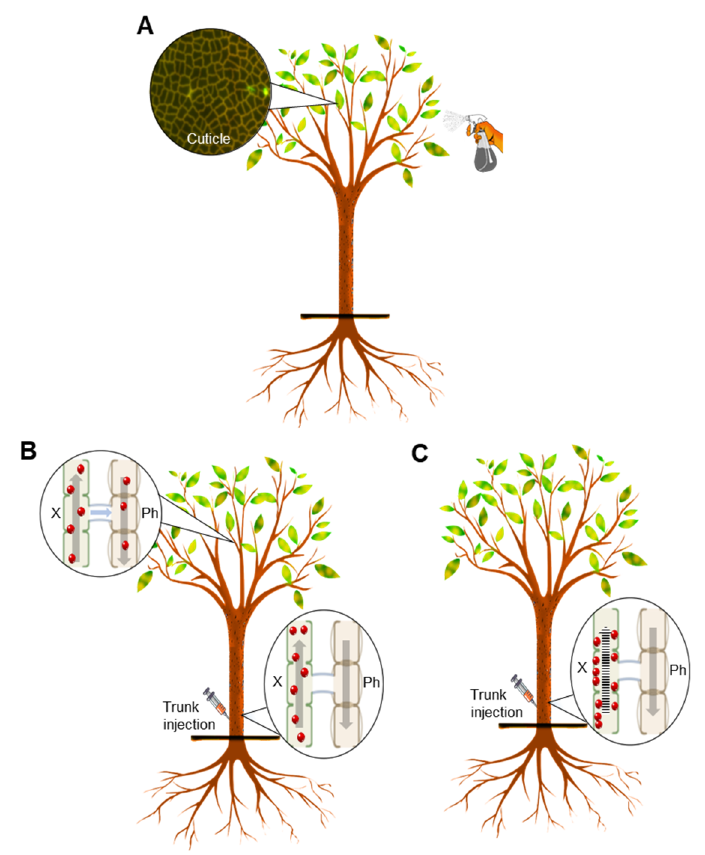
Figure 3. Illustration of efficacy of the different delivery methods for oxytetracycline and streptomycin to citrus trees. ( A ) Foliar application failed to deliver oxytetracycline and streptomycin due to the thickness of the leaf cuticle. ( B ) Oxytetracycline was successfully delivered to foliage after trunk injection. It moves upward via the xylem to the canopy (unidirectional), where it is translocated into the phloem (bidirectional) and distributed to leaves. ( C ) Streptomycin adheres to the cells after trunk injection and is not translocated. Red dots represent anti-microbial compounds. X: xylem. Ph: phloem.